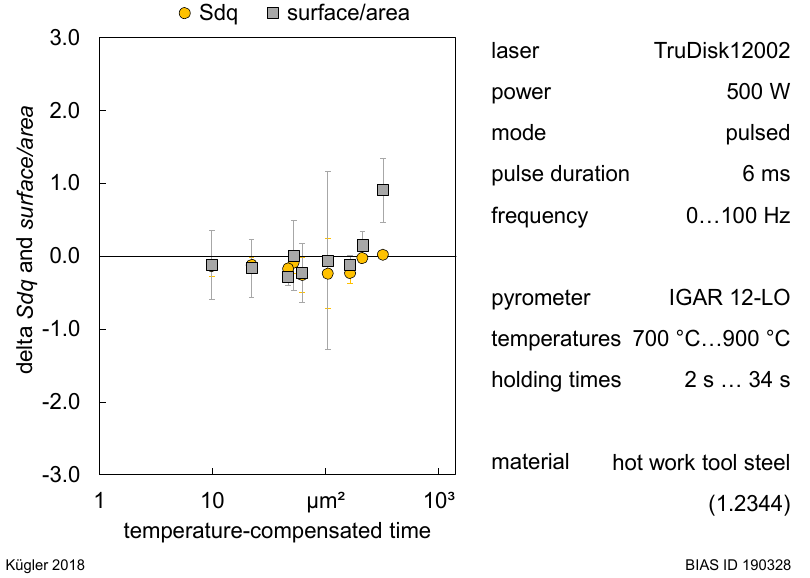
Figure 8. Roughness value Sdq and topography factor surface/area of laser-heated 1.2344 sheets.